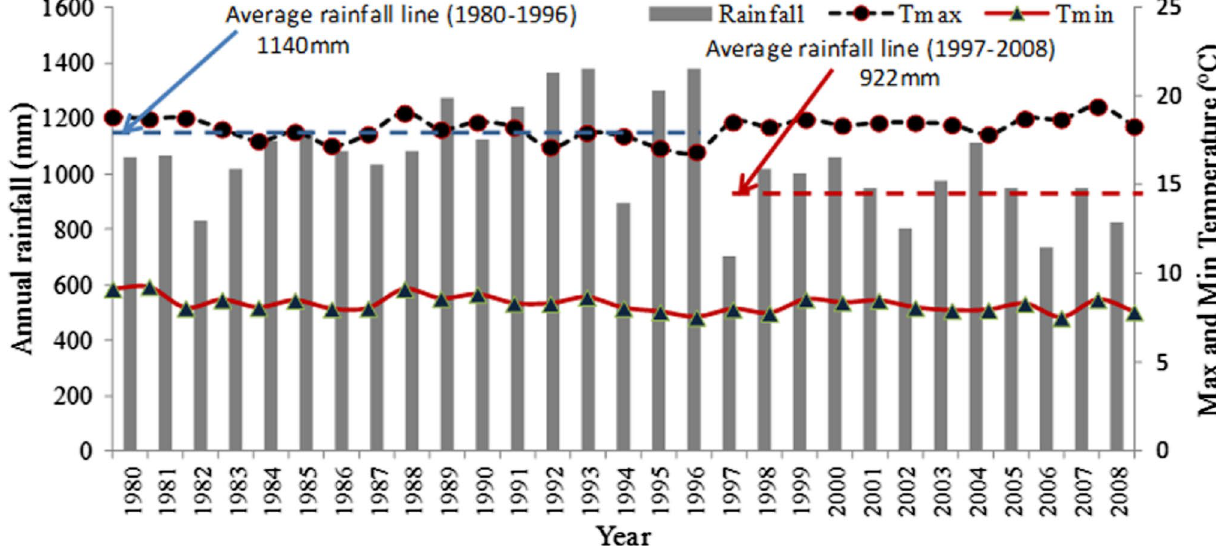
Fig. 4 Relation between yearly temperature and precipitation (min and max) in the